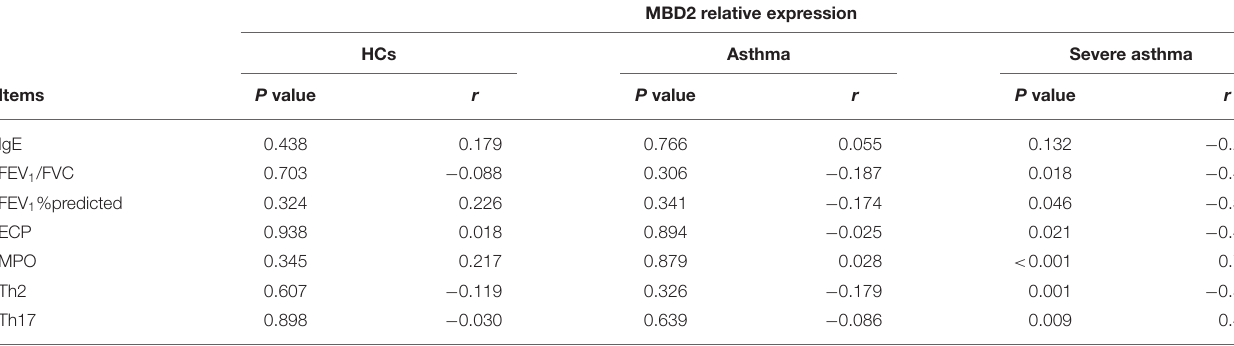
TABLE 3 | Correlation of serum MBD2 levels with clinical characteristics and pulmonary function test results in different groups.